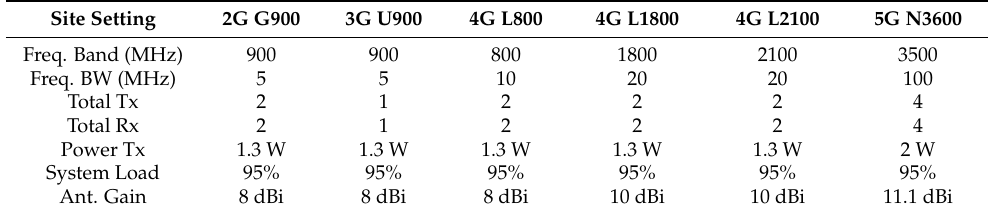
Table 4. Configuration setup for shared indoor IBS.